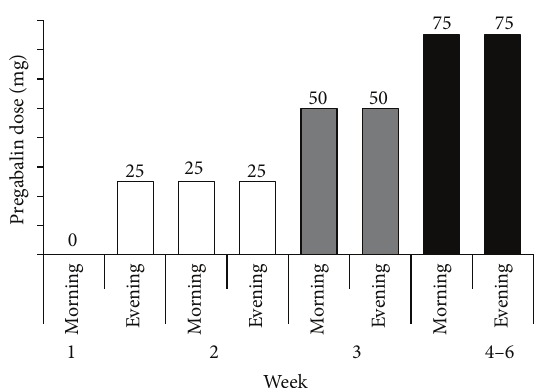
Figure 1: Pregabalin (PGB) treatment schedule. Treatment is initi- ated with the minimum dose (25 mg) administered in the evening, followed by a gradual increase. The maximum dose is 150mg/day depending on the pain